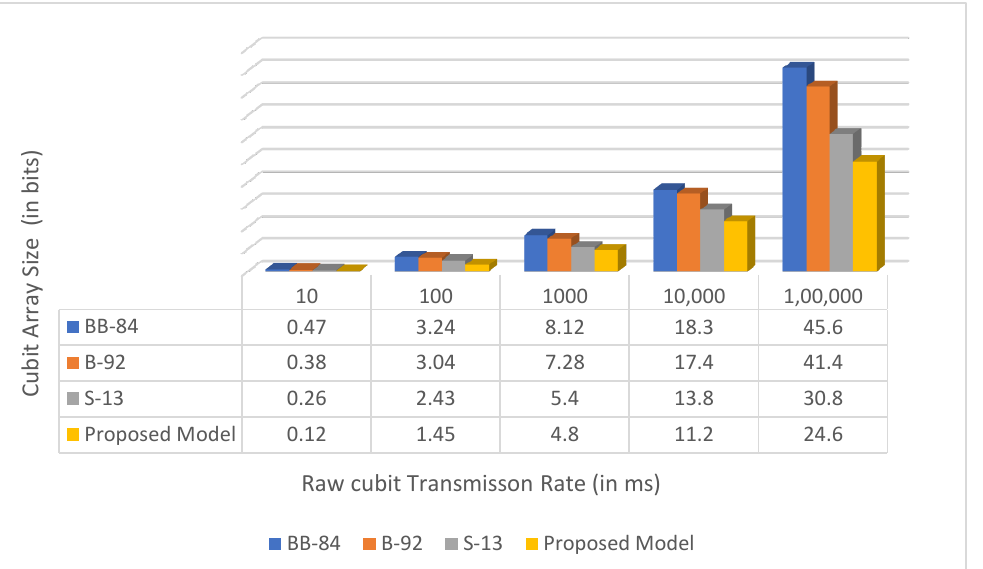
Figure 6. Comparison of the proposed model to the existing models in terms of raw qubit transmis- sion time .